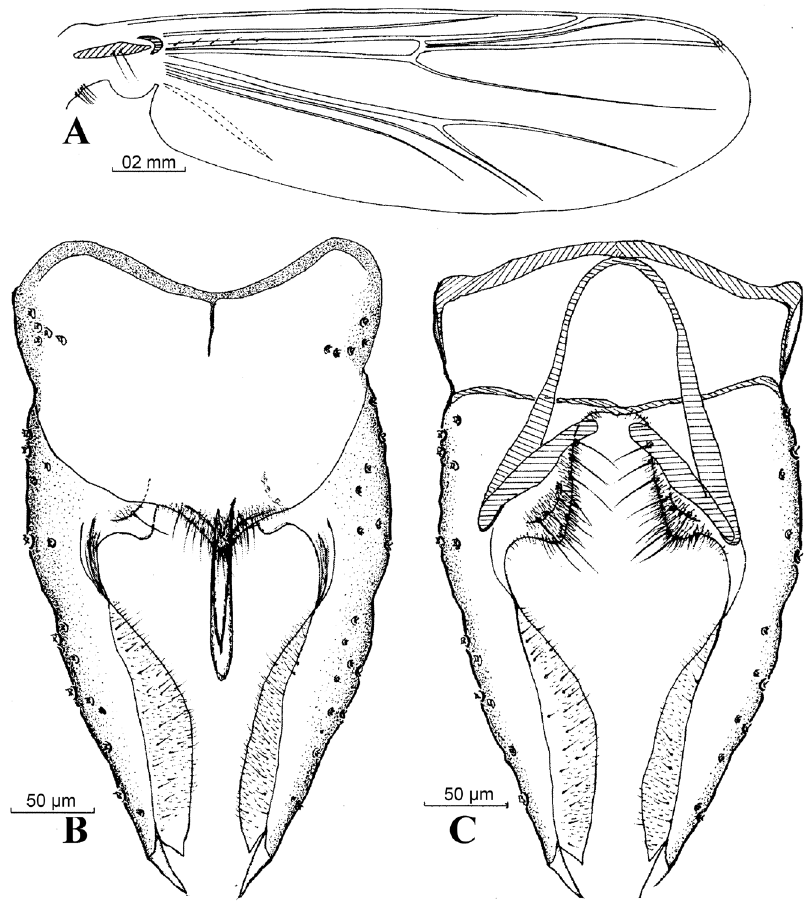
Figure 2. Harnischia cultriata . A Wing; Hypopygium: B (dorsal) C